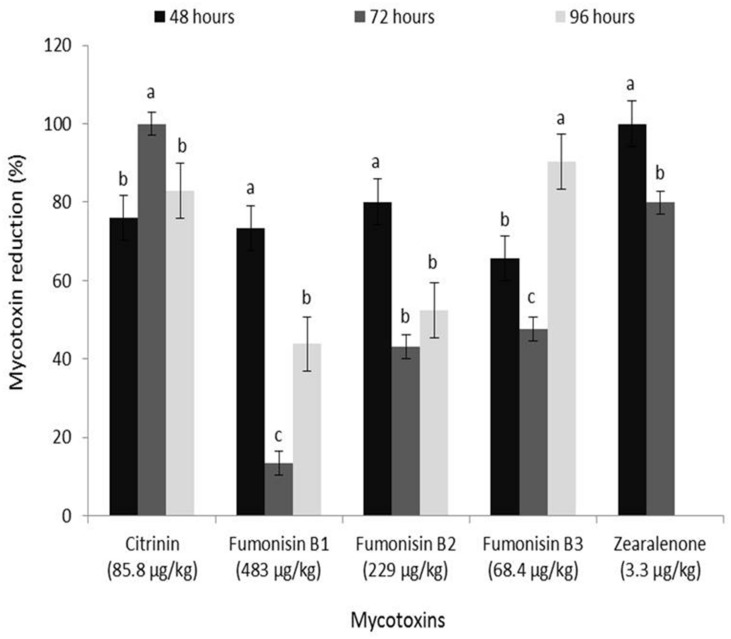
Reduction (%) of mycotoxins in freshly fermented ogi due to fermentation during steeping of white maize grains. Concentrations given on x-axis indicate mycotoxin levels in raw maize grains before steeping. Cyclopiazonic acid (23.5 μg/kg) was reduced by 100% at all time intervals. Vertical lines on bars indicate the standard error of mean (α = 0.05). Bars with different alphabets are significantly different by DMRT at α = 0.05.